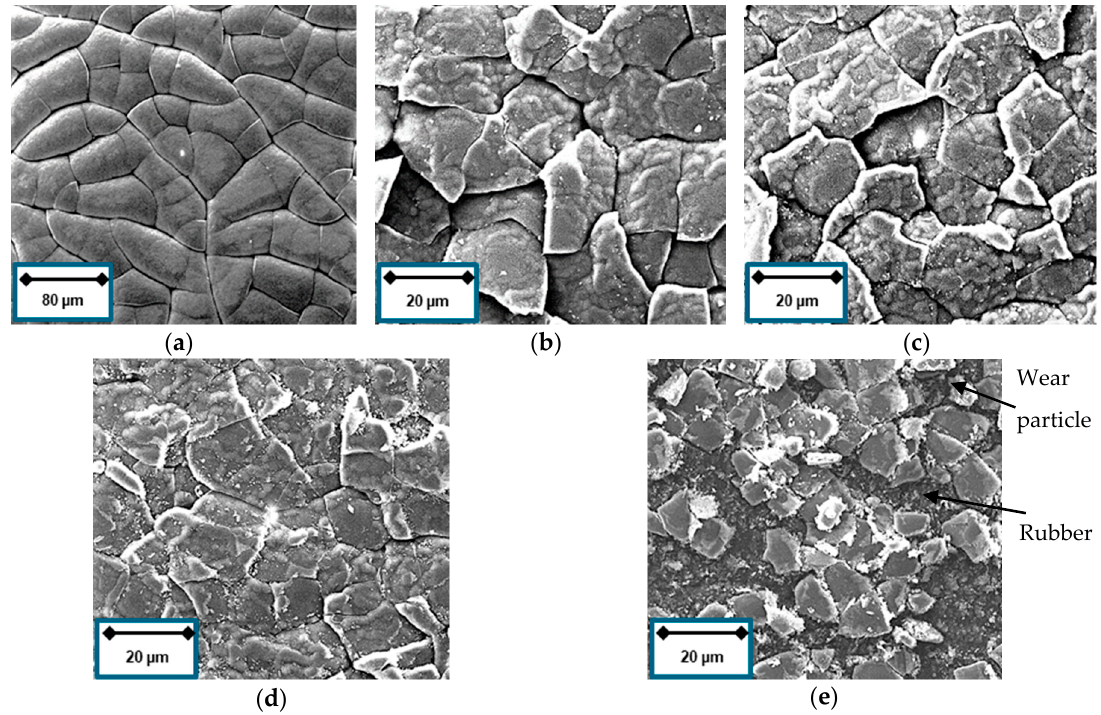
Figure 10. SEM images of coated NBR: ( a ) 1.5 phr before tribotest; ( b ) 1.5 phr; ( c ) 3 phr; ( d ) 6 phr; and ( e ) 9 phr after 3000 laps.